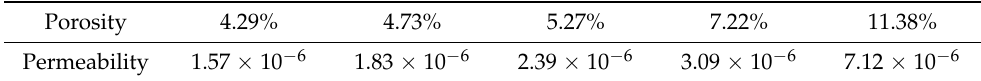
Table 1. The permeances of N 2 passing through the five interlayers.